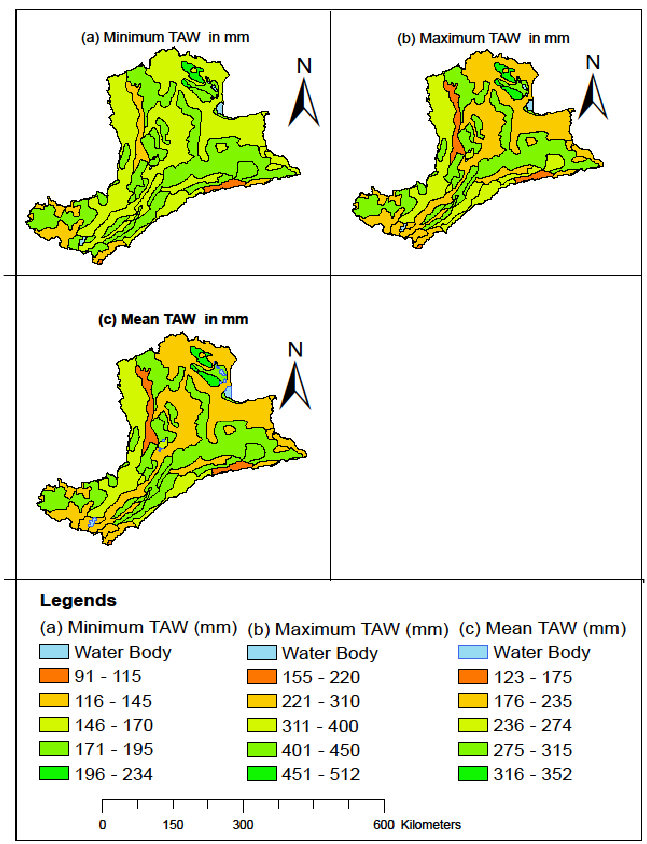
Figure 5. ( a – c ) Total available water ( TAW ) maps for different soil groups in